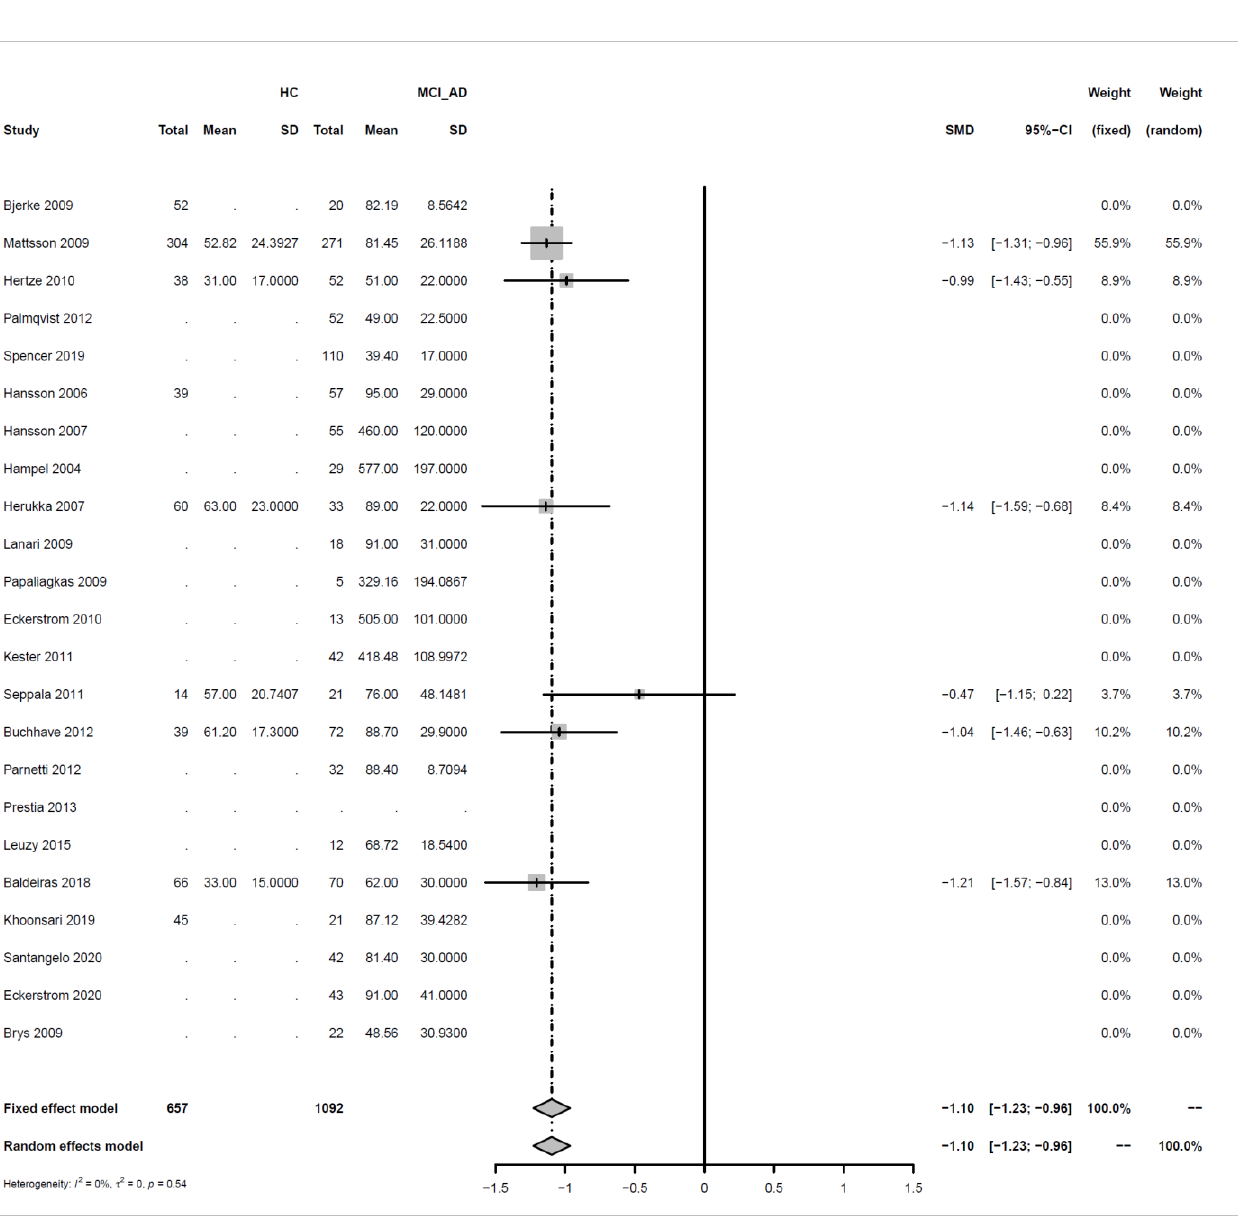
Figure 12. Meta analysis of studies investigating CSF P-tau levels for healthy control (HC) versus progressive MCI (MCI_AD), see Appendix A.4.2 [30,32,34 – 37,44 – 48,50,54,55,57,58].